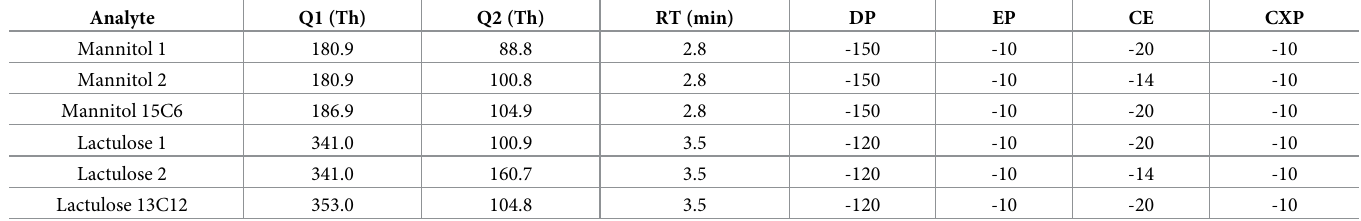
Table 1. Retention time in minutes (RT), dispersion potential (DP), entrance potential (EP), collision energy (CE), collision cell exit potential (CXP) Q1, Q3 in Thompson(Th) for ABSciex 5500 Qtrap MS/MS.